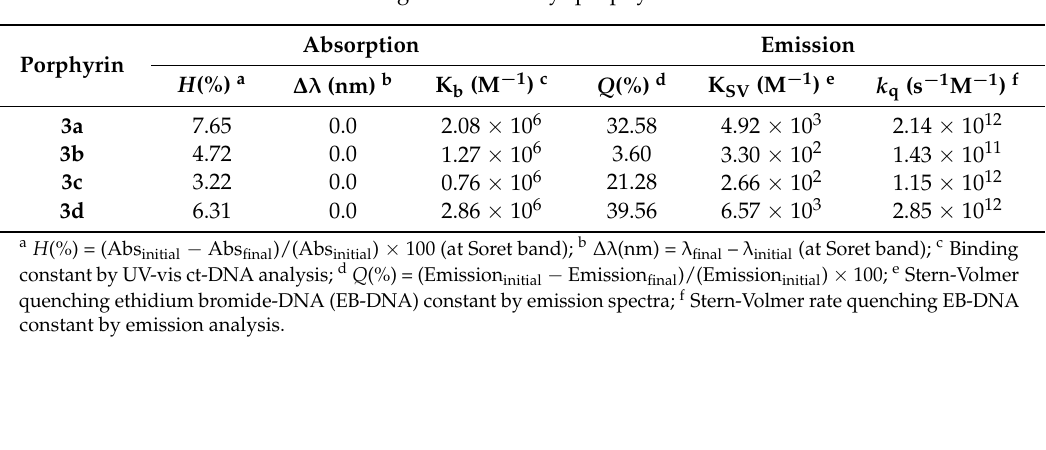
Table 4. DNA-binding data of thioaryl-porphyrin derivatives 3a – d